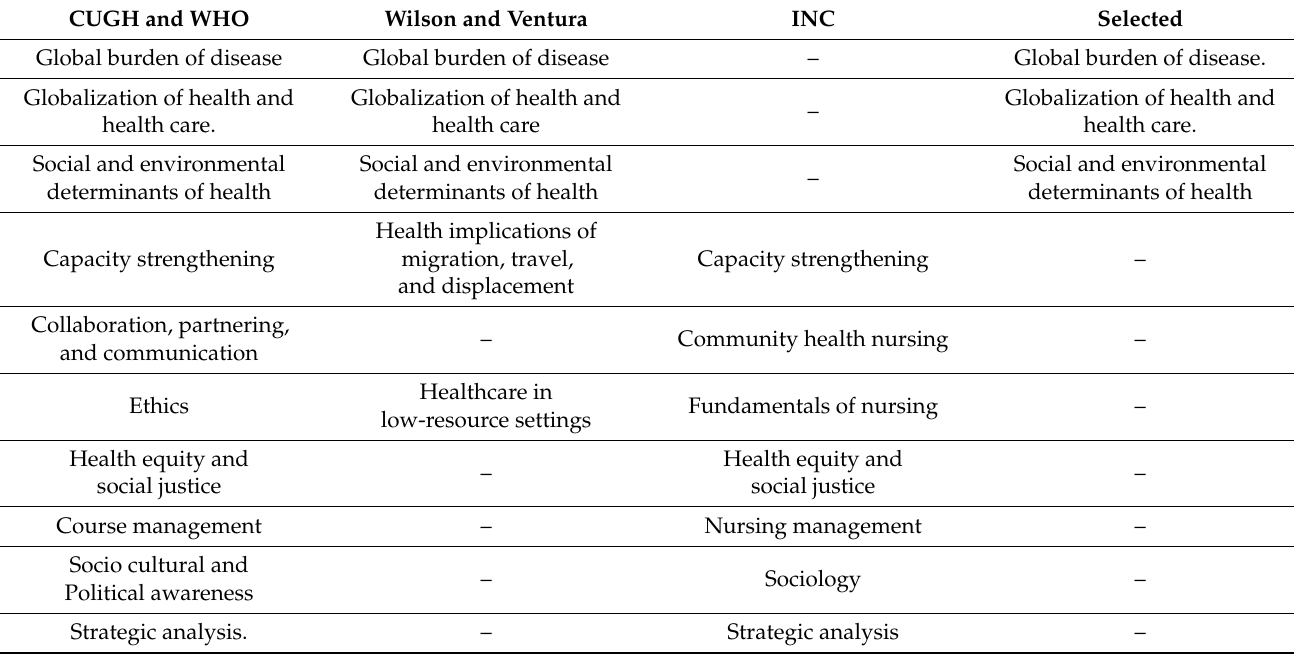
Table 2. Comparison of Global Health Nursing